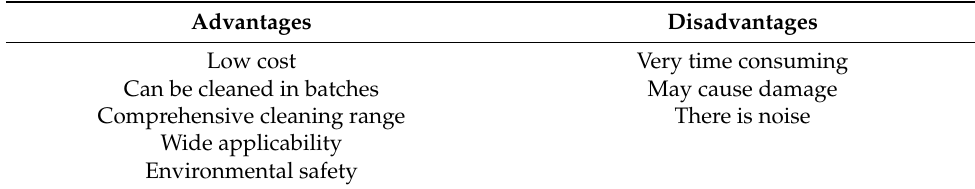
Table 1. The advantages and disadvantages of ultrasonic cleaning.